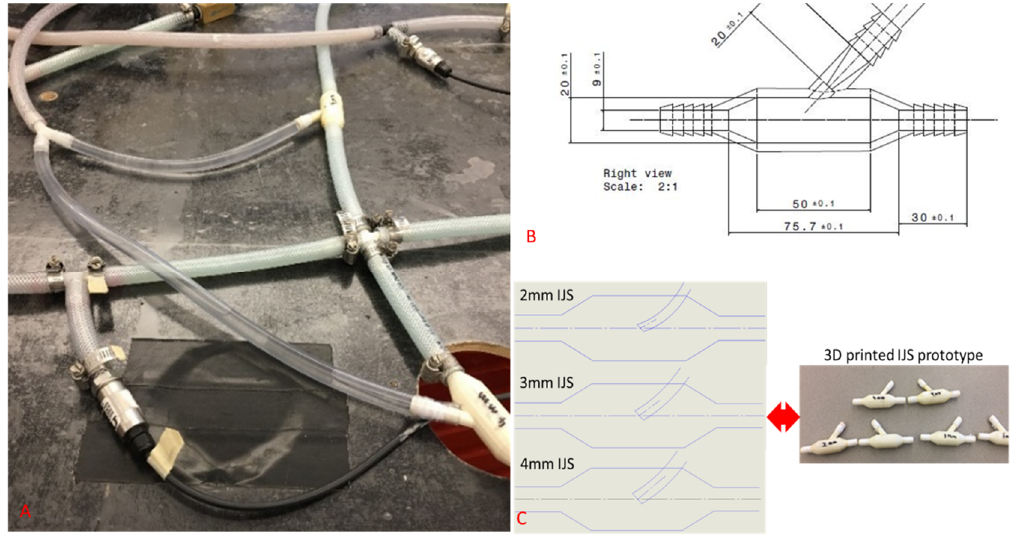
Figure 1. ( A ) IJS prototype placed in MFL ( B ) Schematic diagram of IJS, and ( C ) 2D drawing of 2, 3, and 4 mm IJS models and 3D-printed IJS prototypes.